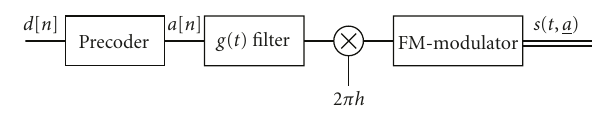
Figure 8: Conceptual modulator for